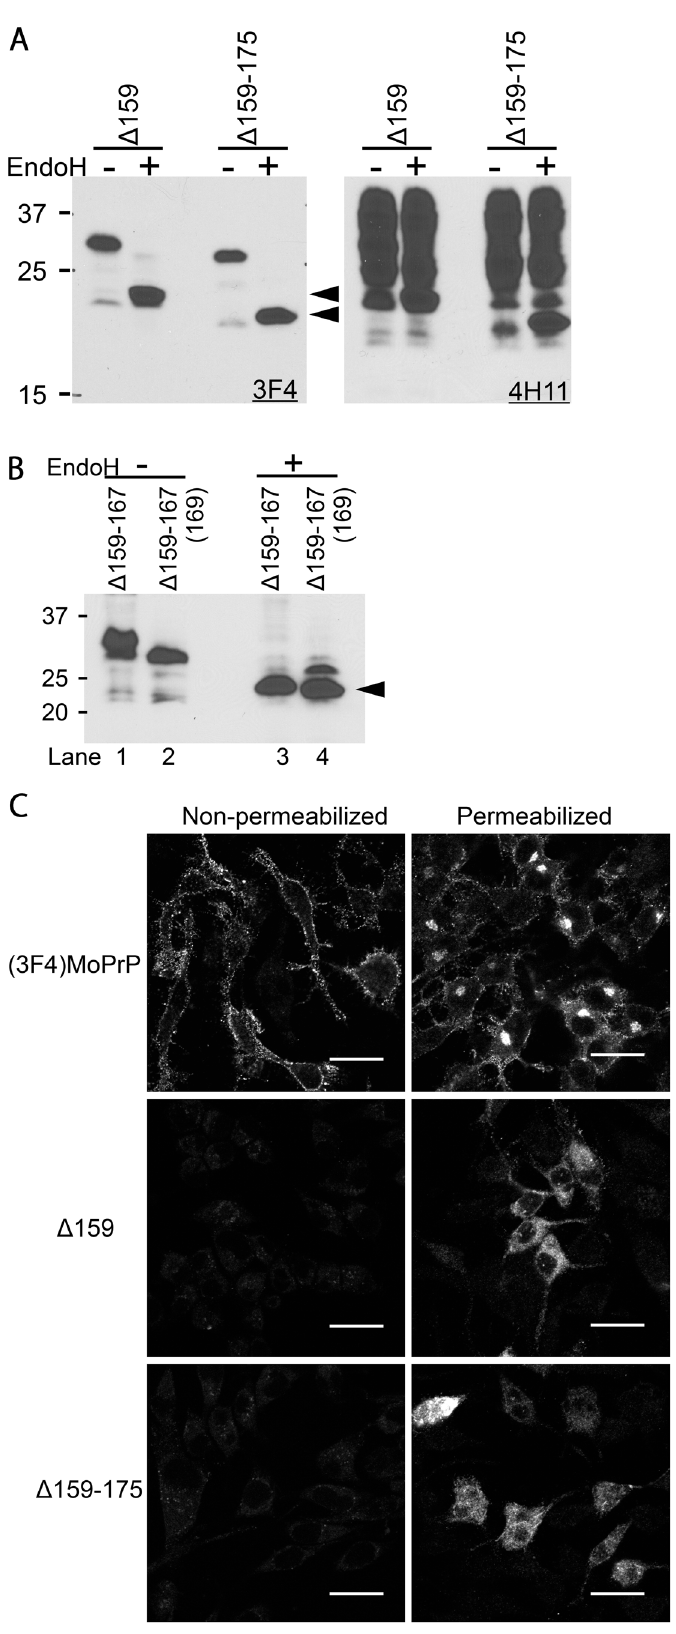
Figure 2. D PrPs are non-complex glycosylated and retained intracellularly. A. N-linked glycans of D PrPs are not complex-type. Immunoblot comparing EndoH- and non-digested lysates of D PrP159 and D 159–175 transfected cells. Left panel was probed with mAb 3F4 mAb, detecting